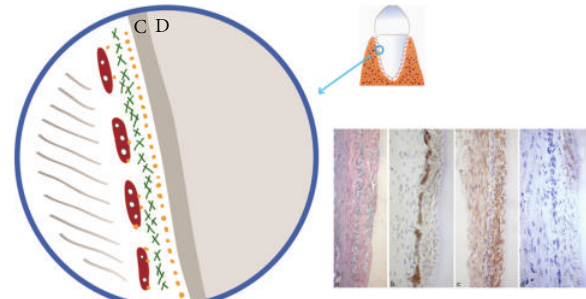
Figure 6: Schematic drawing of the cell layer in the root-close part of the periodontal membrane. D is root dentin and the cement layer C is marked on the surface. A layer of peripheral nerves (yellow dots) is seen the closest to the cement layer. Above is a dense fibre layer of ectomesenchymal origin (green lines) and outermost towards the more loose periodontal membrane the epithelial rests of Malassez are located (reddish-brown). This structured layer is called the peri-root sheet. Inserted in the figure are previously published histological sections showing the three cell layers